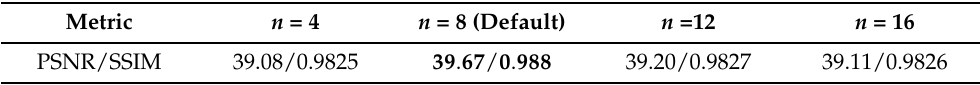
Table 4. Ablation study on number of subspaces for